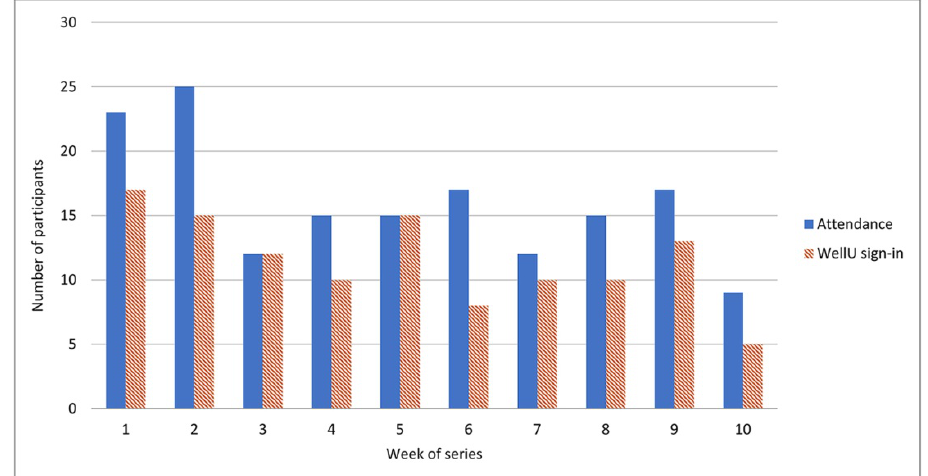
Figure 1 Trial series attendance and WellU sign-in